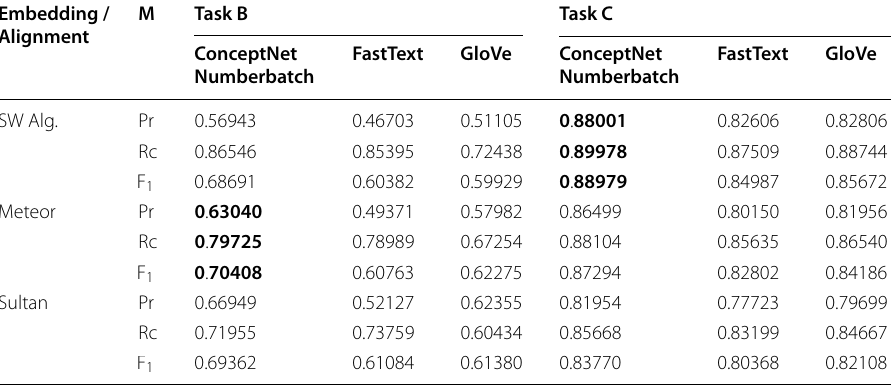
Bold values refer to the highest values of F 1 scores of each task